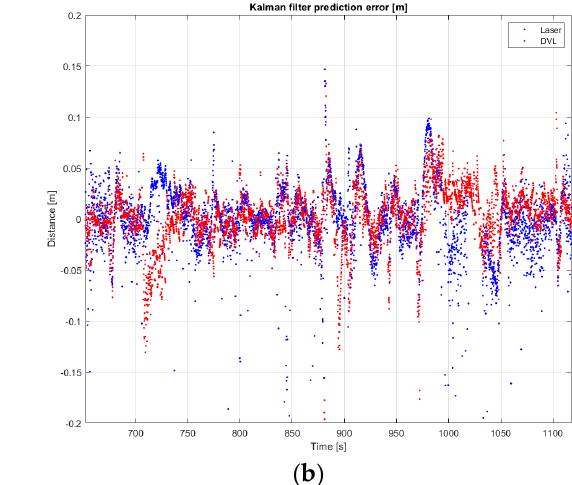
( b ) Figure 17. Zoomed in distance measurements from the laser triangulation sensor and the DVL which show quantization effects.